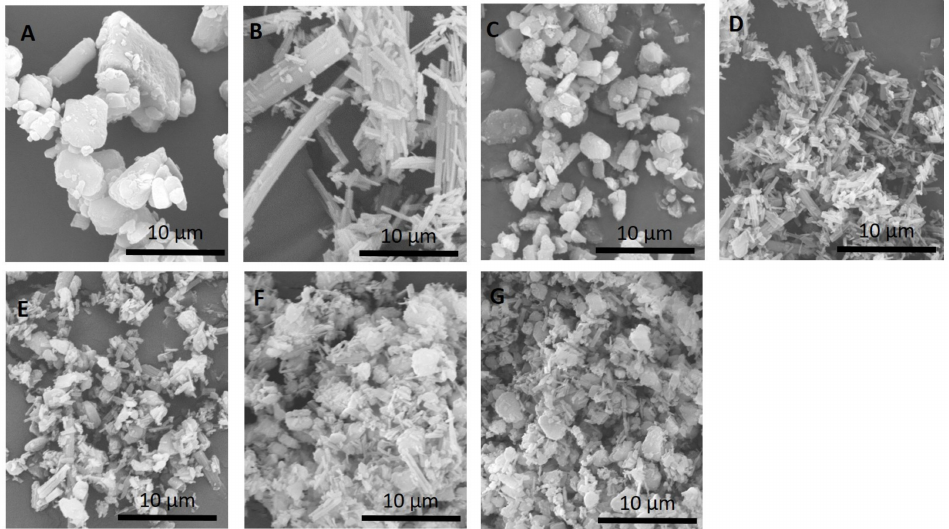
Figure 1. SEM images of ( A ) raw CUR, ( B ) raw PTX, ( C ) jet-milled CUR, ( D ) jet-milled PTX and the combination of milled CUR/PTX at different ratios (( E ) 25CUR:75PTX, ( F ) 50CUR:50PTX